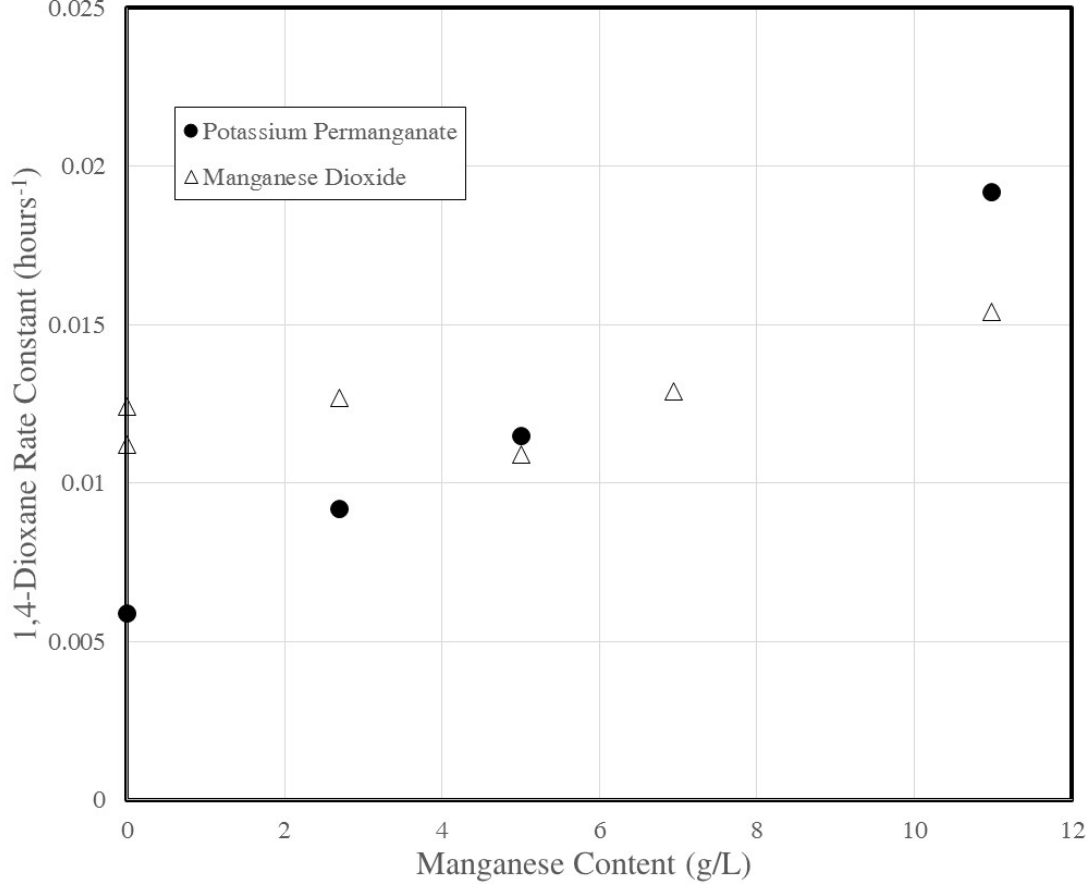
Figure 6. 1,4-D degradation rate constant versus Mn content for experiments conducted with presence of 49 mM PS and different concentrations of MnO 2 or KMnO 4